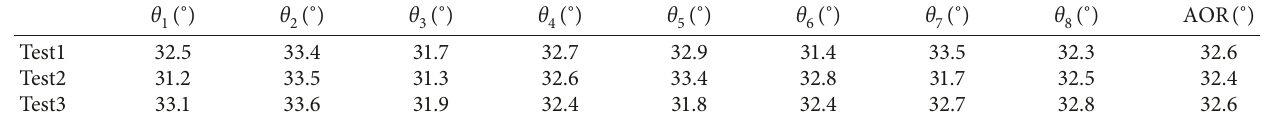
Table 1: The measured angles of repose in CLT and the average value for each